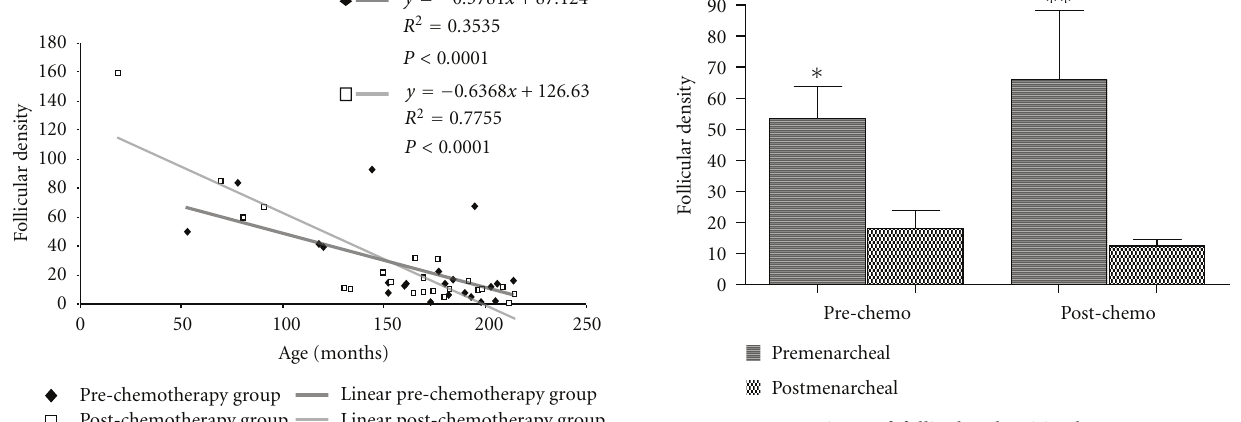
Figure 2: Comparison of follicular densities between premenar- cheal and postmenarcheal patients in pre- and post-chemotherapy groups. ∗ P < 0 . 05; ∗∗ P < 0 . 001.